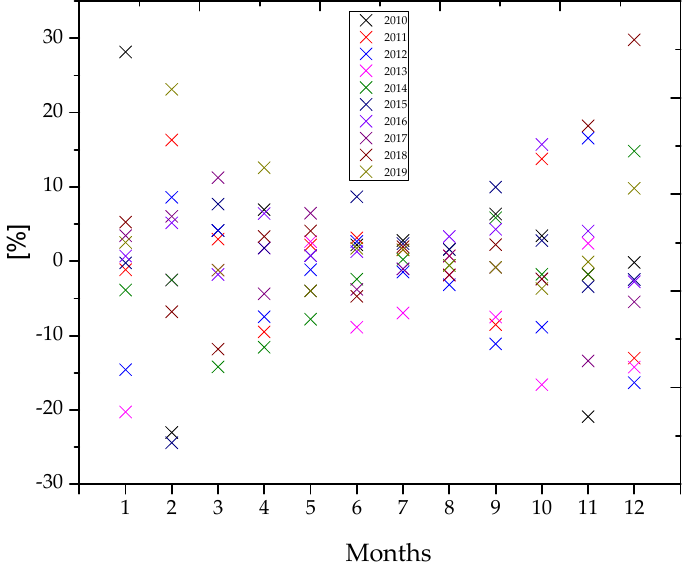
Figure 4. Monthly variation of solar irradiation for 10-years period (actual data for Athens area) [88].